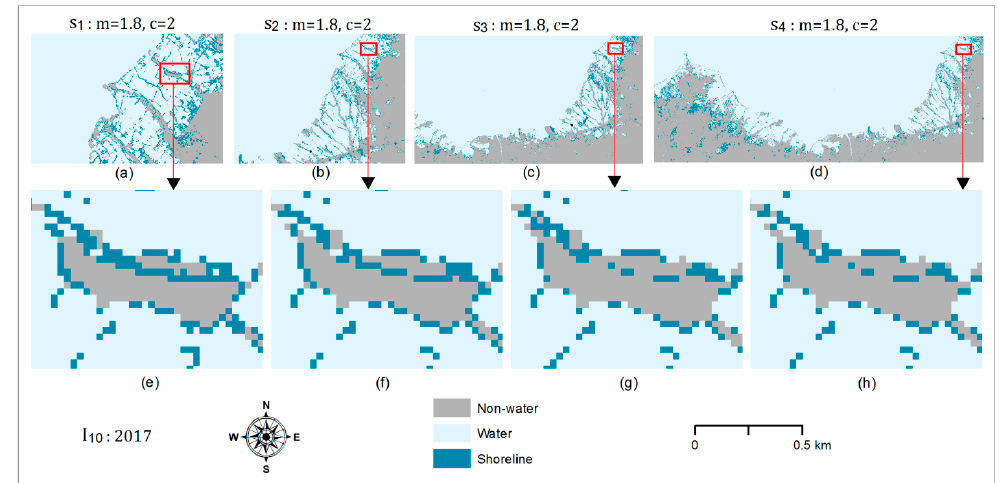
Figure 8. Image I 10 is used to show the comparison of shoreline images developed at the reference subset ( a ) and the target subsets ( b – d ) by setting m = 1.8 and c = 2 as the optimal values for both parameters. We zoom into an area in the red rectangle site ( e – h ) to see a variation of shoreline margins (in turquoise) each time we upscaled the method to a larger area. The larger the area, the larger the deviation of shoreline margin from its reference subset.